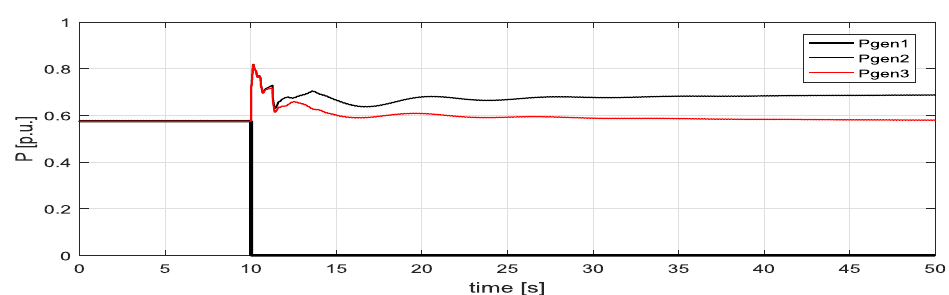
Figure 12. Time evolution of voltage on the busbar at 33 kV.